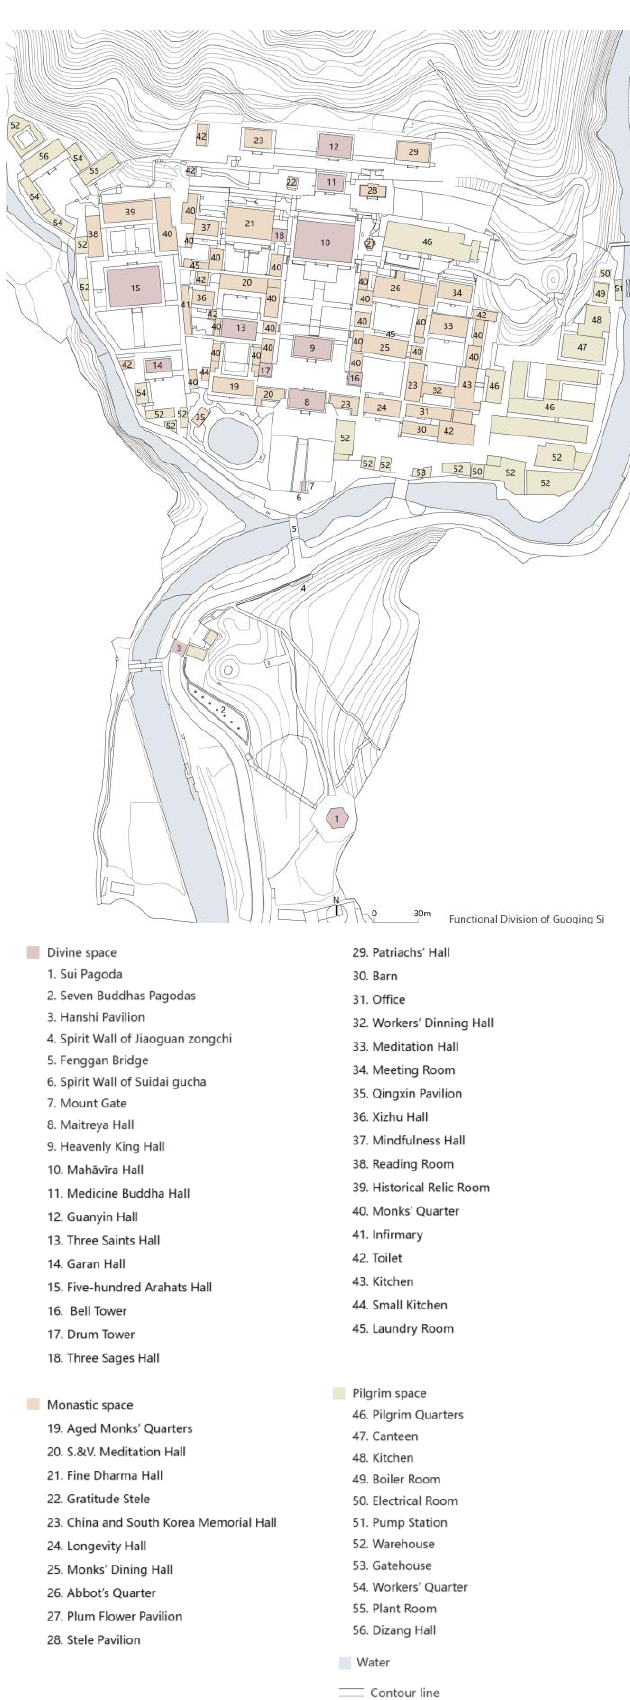
Figure 5. Functional division of Guoqing Si.